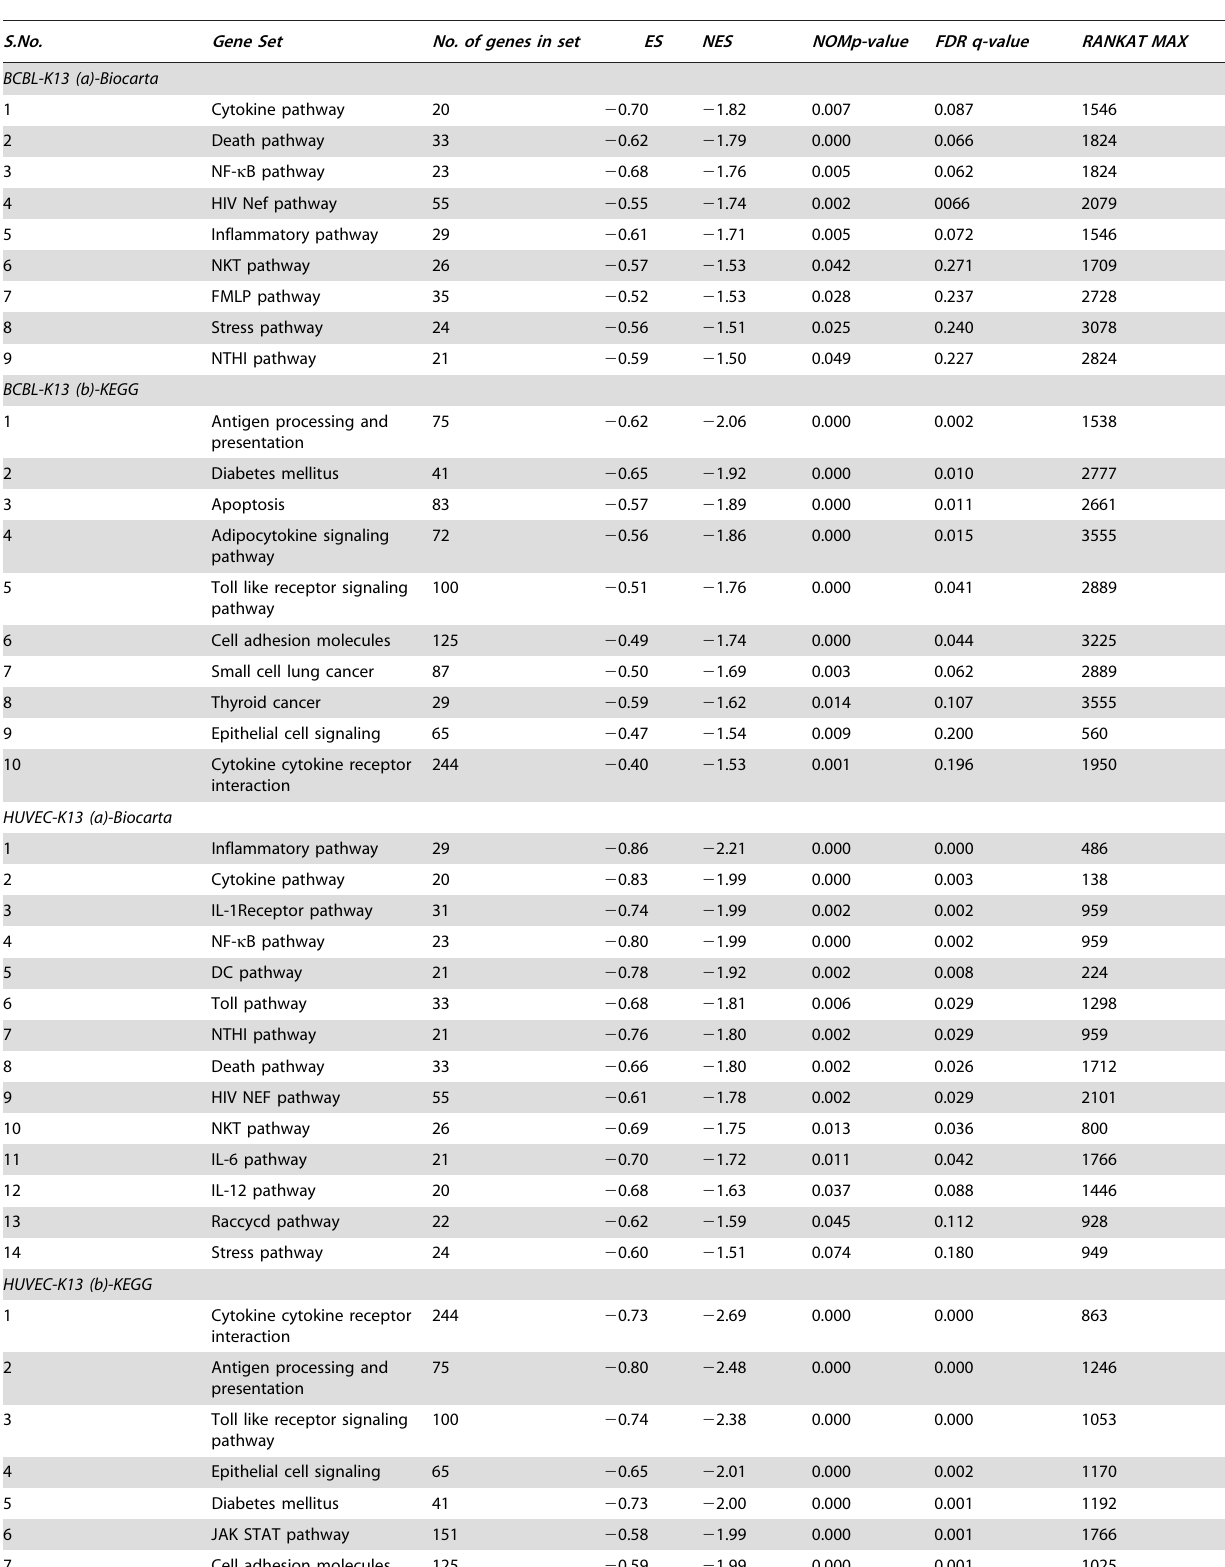
Table 2. Gene sets enriched in BCBL-K13 and HUVEC-K13 cells (a) Biocarta gene sets, (b) KEGG (Kyoto Encyclopedia of Genes and Genomes) gene